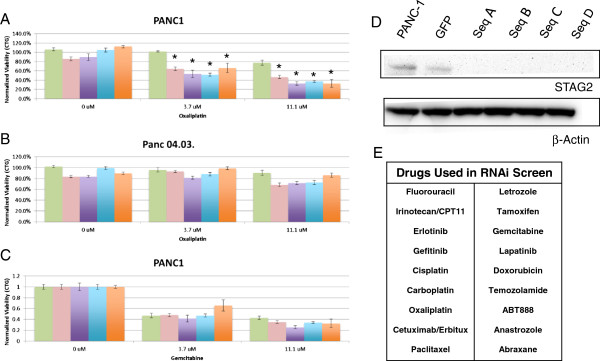
Synthetic lethal analysis of STAG2 knockdown and exposure to chemotherapeutic agents in PDA cells. (A) Synthetic lethal response of PANC-1 cells and (B) Panc 04.03 cells in the presence of oxaliplatin. (C) Absence of response of PANC-1 cells in the presence of gemcitabine. Asterisks indicate that all four siRNA sequences at drug concentrations of 3.7 and 11.1 μM have P < 0.01 when compared to GFP control. Error bars in (A-C) represent standard deviations. (D) Western blot of STAG2 expression in PANC1 cells in the presence of control (GFP) and four STAG2 siRNAs. (E) Drugs used in siRNA synthetic lethal screen.